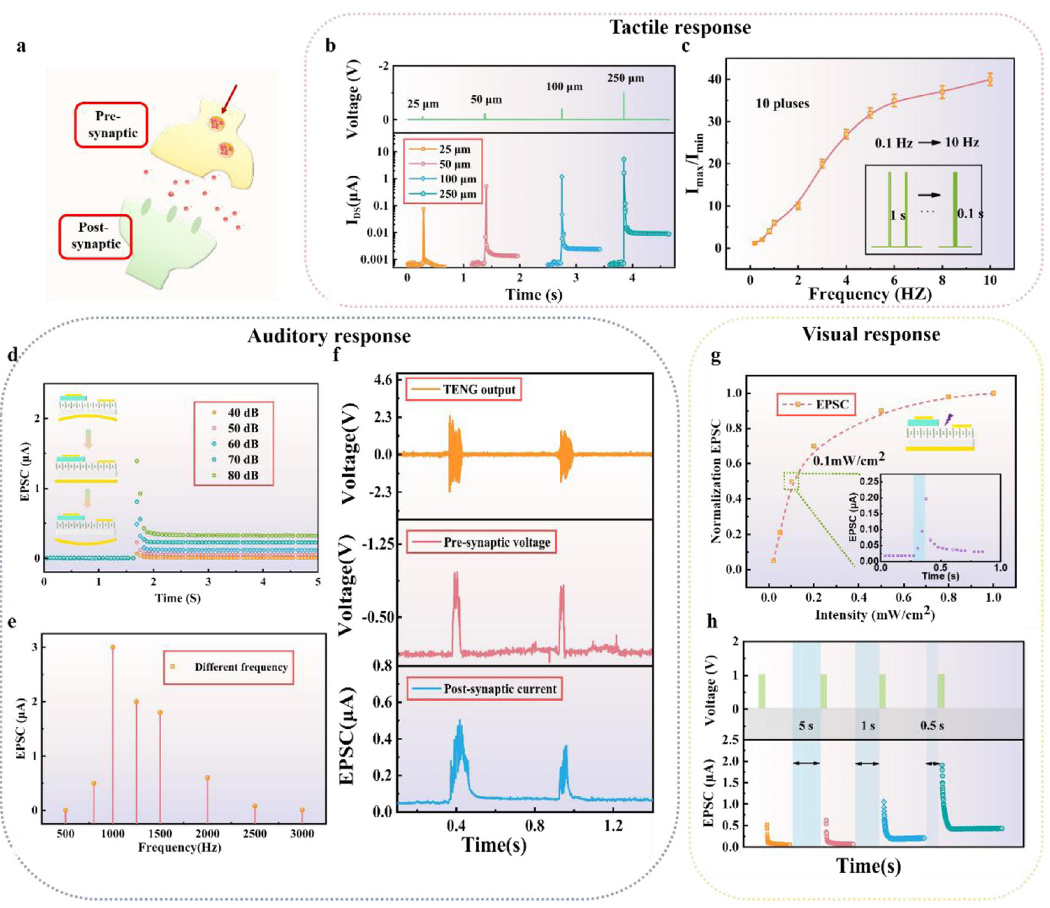
e EPSCs of VTT with different sound frequencies. f Recorded TENG output, pre- synapticvoltageandcorrespondingpost-synapticcurrent. g Thevisualresponseof ourVTTNormalizationEPSCswithdifferentlightintensity. h EPSCamplitudeswith two successive light pluses with different interval